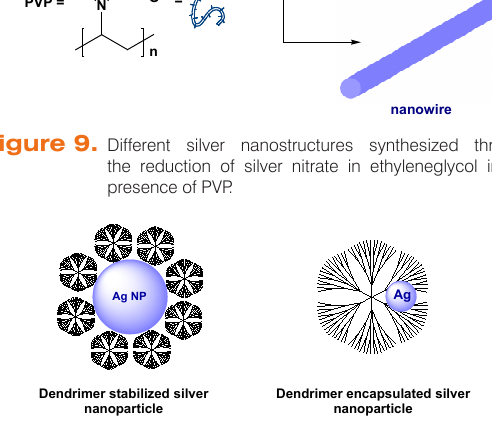
Figure 10. Dendrimer stabilized Ag NPs (left) and dendrimer encapsulated silver nanoparticles (right).